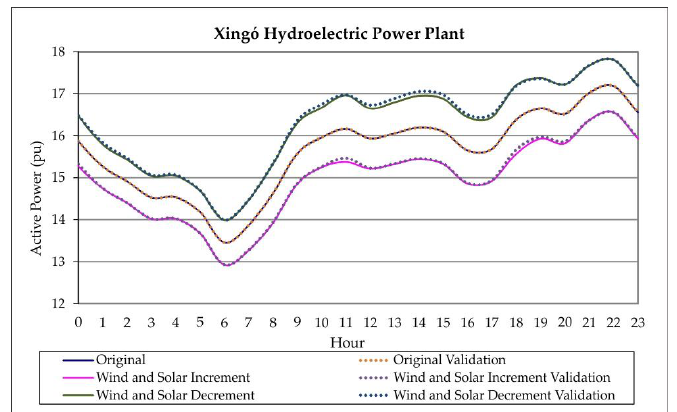
Figure 5. Authentication—active power of Xingó hydroelectric power plant.